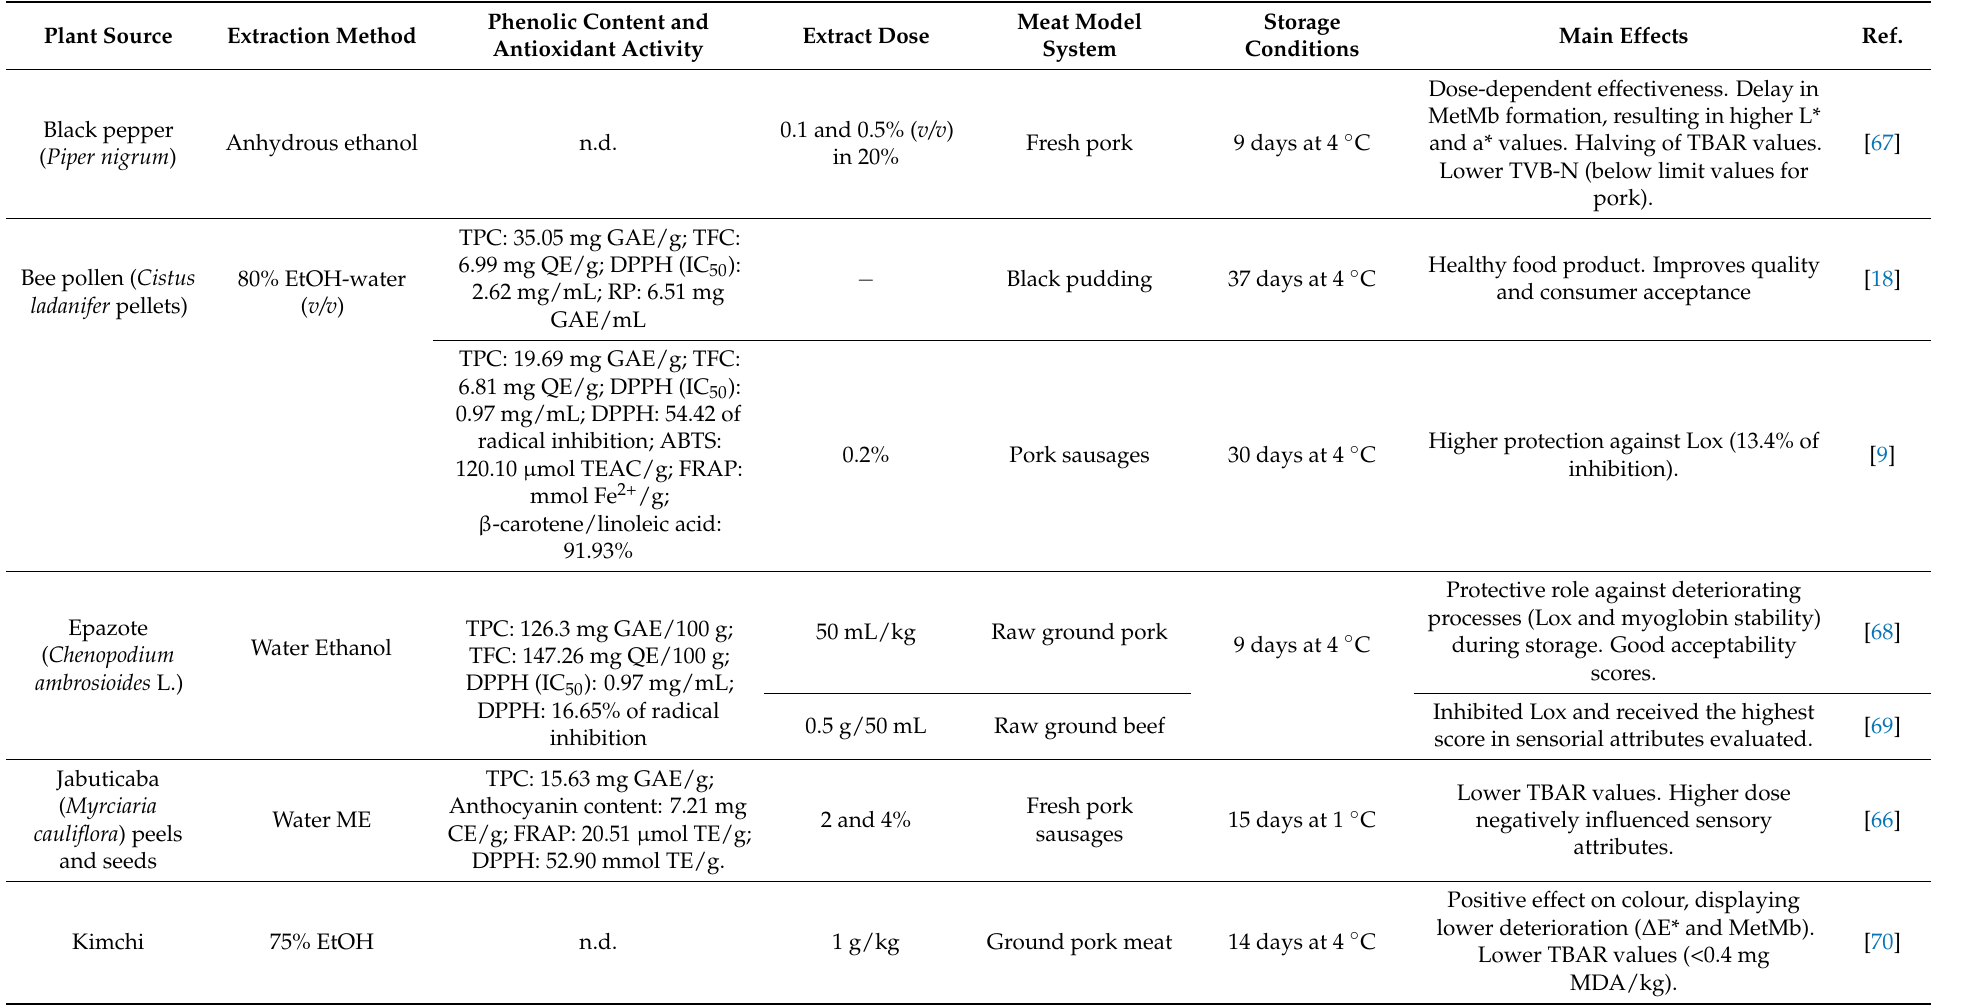
Table 2. Application of natural antioxidants extracted with green solvents from plants in meat and meat